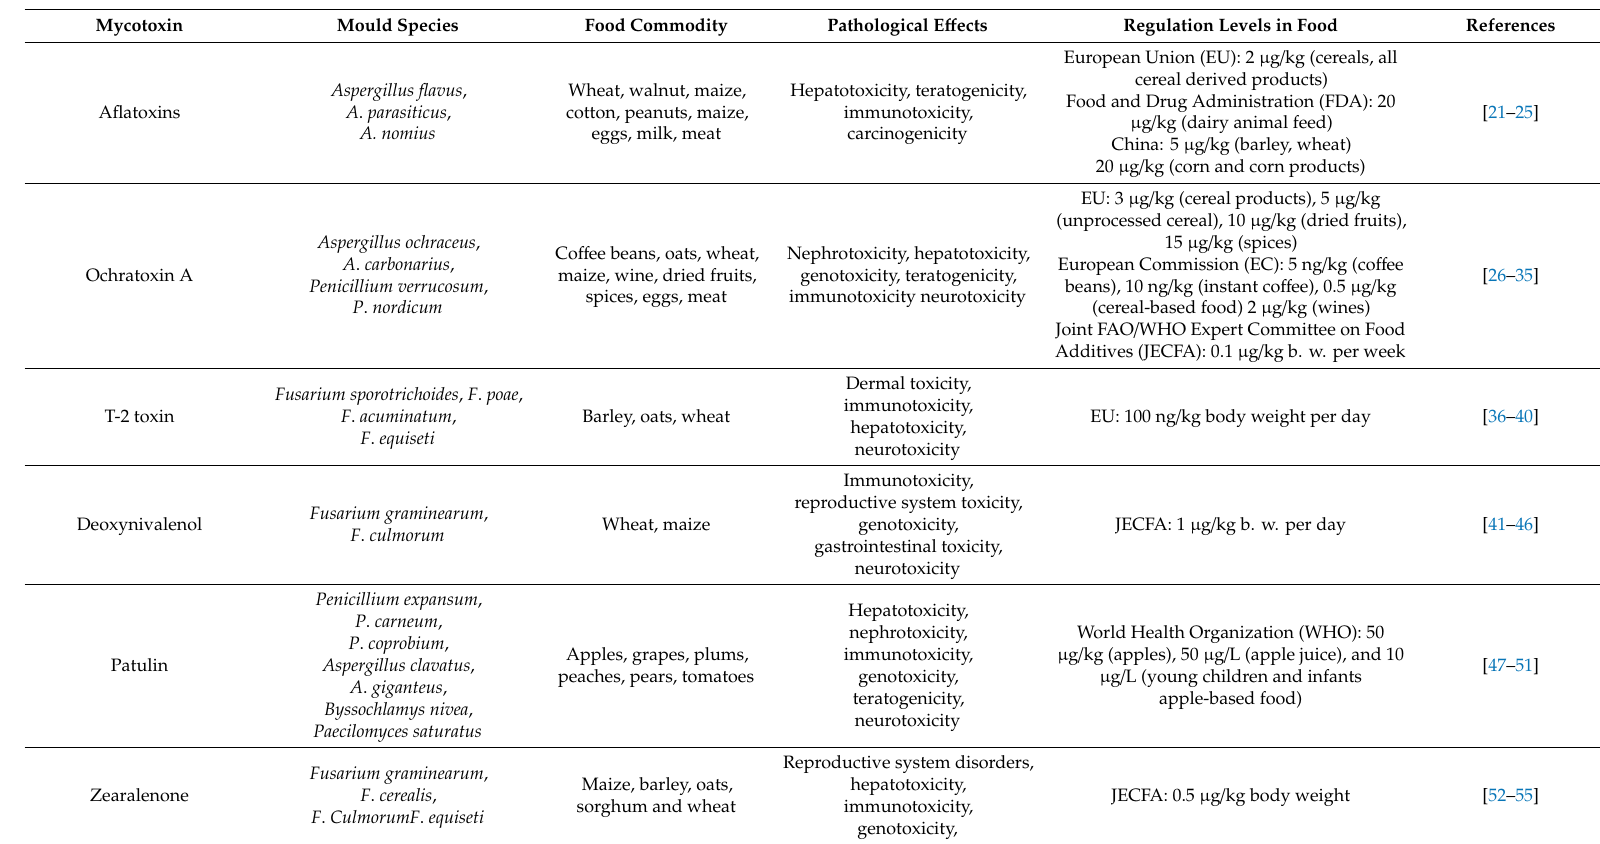
Table 1. The List of Main Mycotoxins Found in